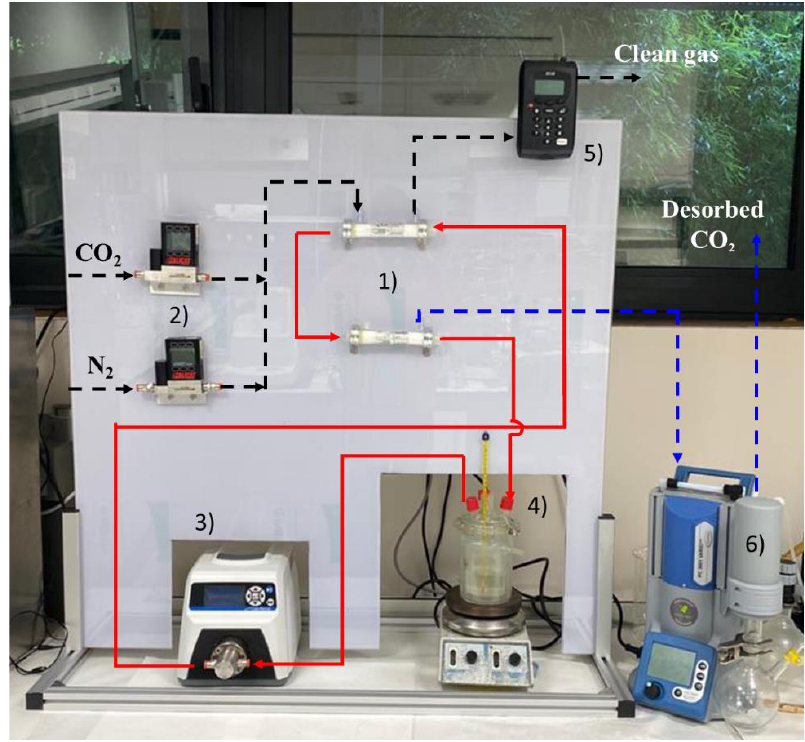
Figure 2. Experimental set-up of continuous absorption–desorption process using MVR technol- ogy.